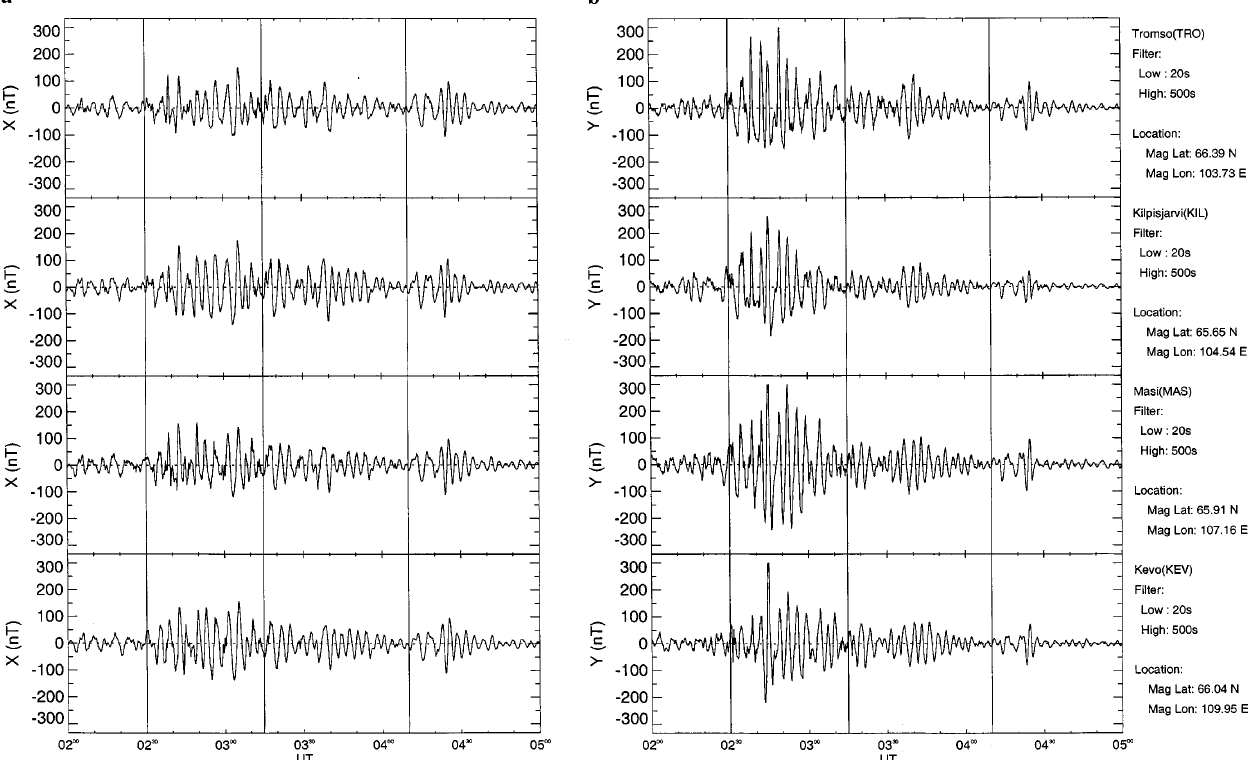
Fig. 1a, b. Band-pass filtered magnetometer data between 0200 and 0500 UT from Tromso (TRO), Kilpisjarvi (KIL), Masi (MAS) and Kevo (KEV). The filter bandwidth is 20 to 500 s. The X components